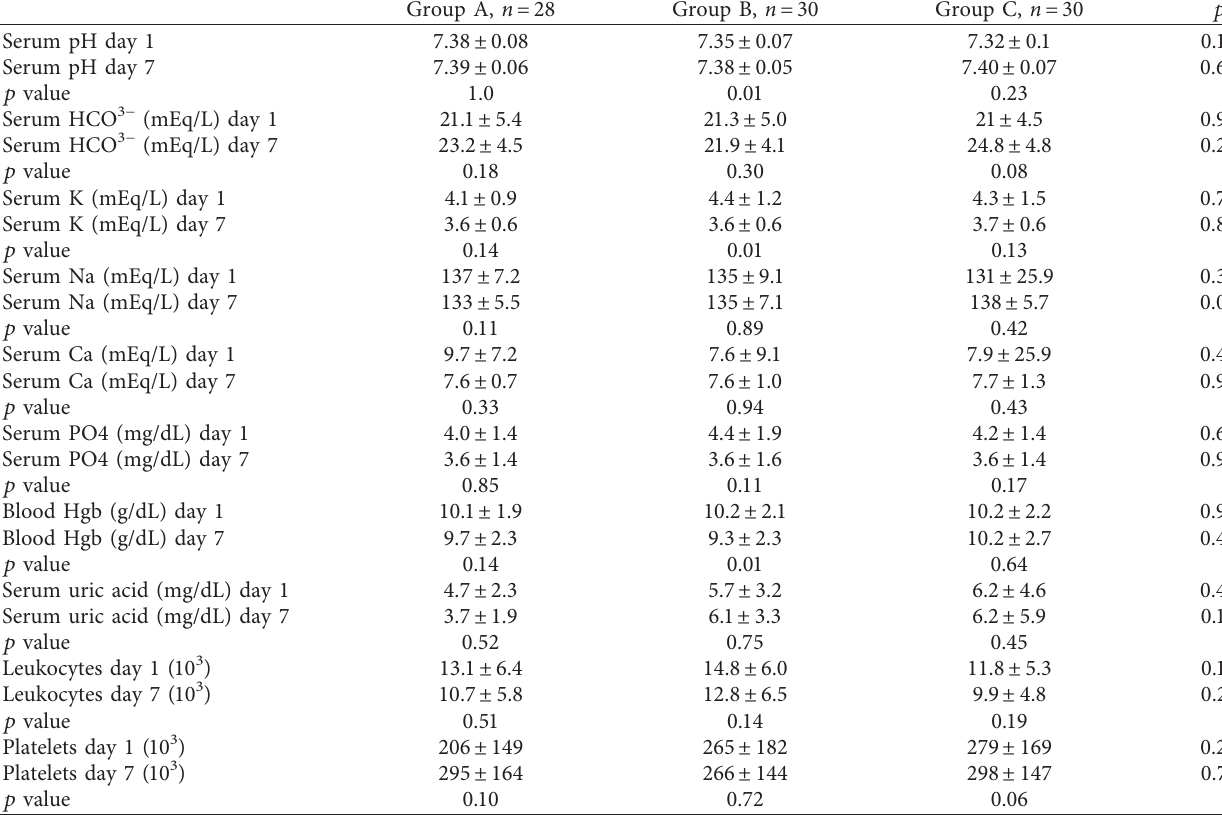
Table 2: Variables of the study from day 1 compared to day 7 according to the study group.